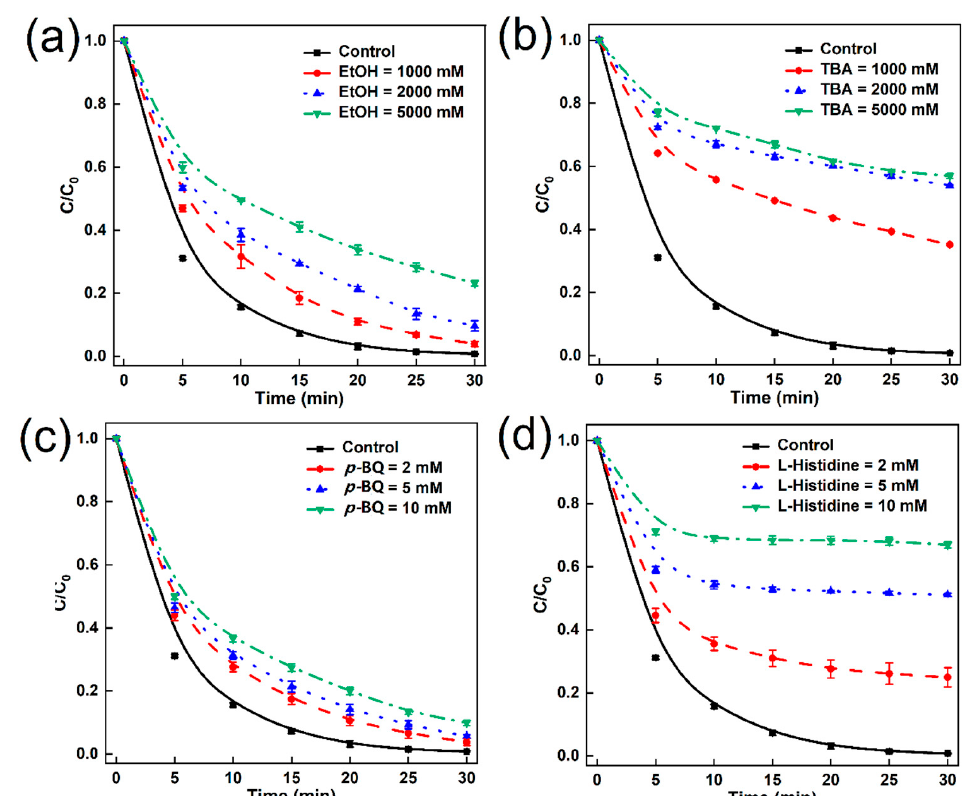
Figure 8. Effect of quenching agents on the degradation efficiency of AO7 (( a ): EtOH, ( b ): TBA, ( c ): p-BQ, ( d ): L-Histidine). Reaction conditions: LLC800 = 0.25 g/L, PS = 4 g/L, AO7 = 200 mg/L, temperature = 25 °C and pH = 6.4 ± 0.1.